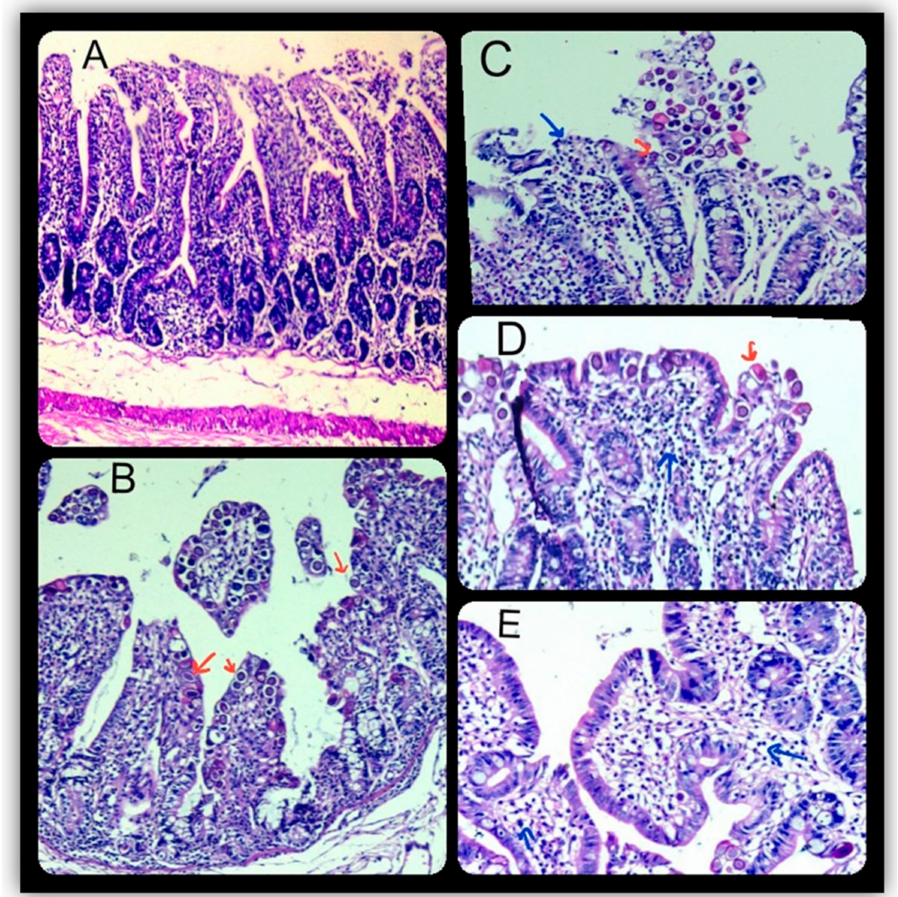
Figure 2. Microscopic findings in the intestines in the different experimental groups indicating: ( A ) apparently normal structure (HE × 100) in the negative control group, ( B ) positive control group showing sloughing and desquamation of the intestinal lining and different developmental stages of Eimeria spp. (red arrow) with lymphocytic infiltration (blue arrow) in the lamina propria and edema in the submucosa (HE × 100). ( C – E ), intestines from rabbits in the herbal treated groups showing a mild degree of sloughing of the epithelium lining and less infiltration with coccidial oocyte-infected epithelium (HE × 200). Data obtained from 3 rabbits/group. Blue arrow is pointing to lymphocytic infiltration in the epithelial lining while red arrow is pointing to developmental stages of Eimeria